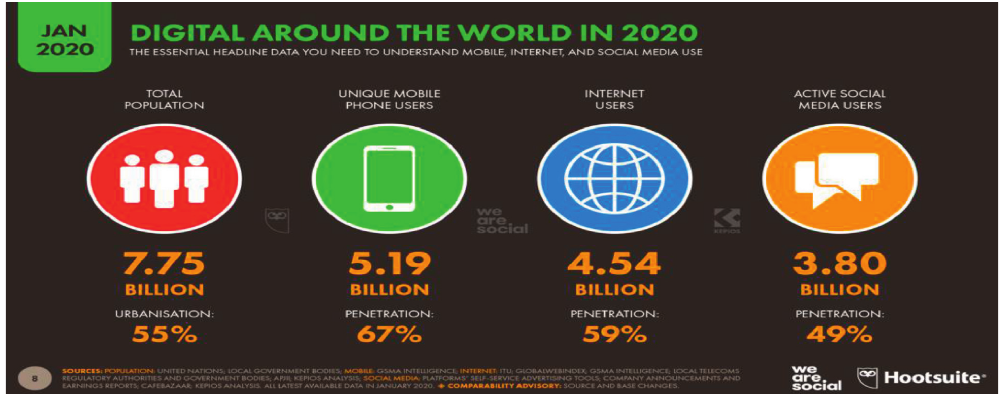
Figure 1: Number of social media users (Global Digital Yearbook).